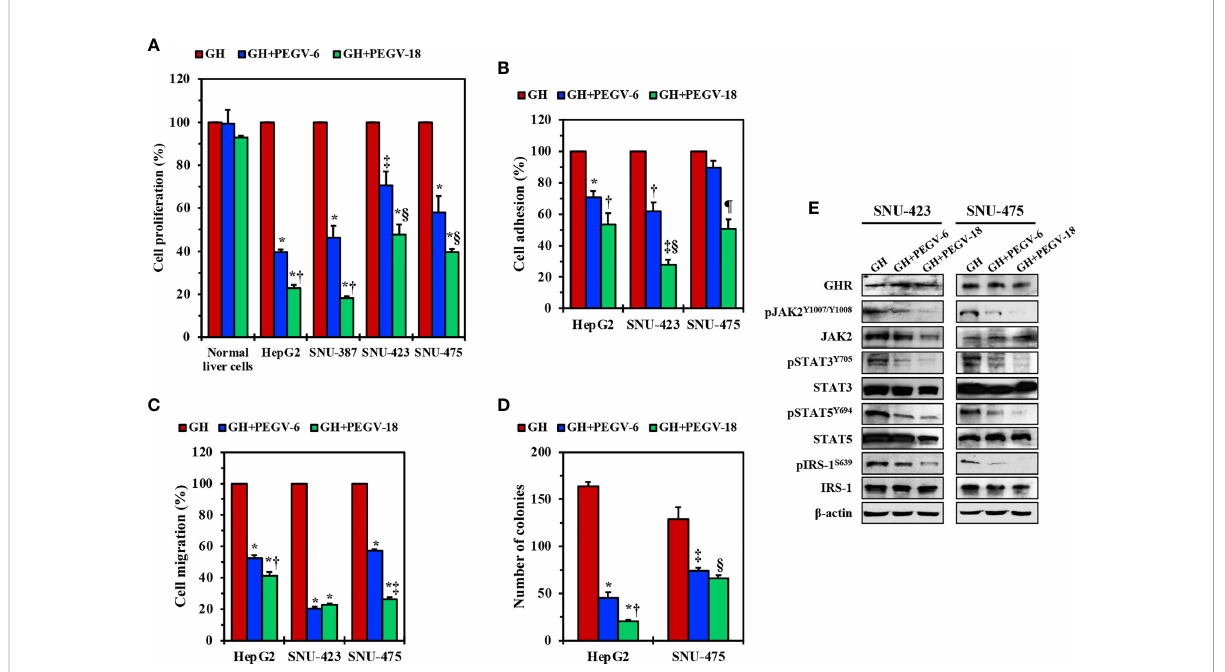
FIGURE 4 Effects of inhibition of GH/GHR signaling by using pegvisomant. In the presence of GH, pegvisomant (PEGV in the fi gure) at a concentration 6.0 or 18.0 µg/mL for 48 hours decreased cell proliferation in HepG2, SNU-387, SNU-423, and SNU-475 cells, which was not detected in normal liver cells (A) *P<0.0001 vs. GH; † P<0.0001 vs. GH+PEGV-6; ‡ P<0.01 vs. GH; § P<0.05 vs. GH+PEGV-6. In addition, pegvisomant decreased the adhesion (B) *P<0.01, ‡ P<0.001 vs. GH; ‡ P<0.001 vs. GH+PEGV-6; § P<0.0001 vs. GH; ¶ P<0.01 vs. GH and GH+PEGV-6 and migration (C) *P<0.0001 vs. GH; ‡ P<0.01 vs. GH+PEGV-6; ‡ P<0.0001 vs. GH+PEGV-6 of HepG2, SNU-423, and SNU-475 cells. Furthermore, treatment of HepG2 and SNU-475 cells with pegvisomant reduced anchorage-independent colony formation potential (D) *P=0.0001 vs. GH; ‡ P<0.05 vs. GH +PEGV-6; ‡ P=0.01 vs. GH; § P<0.01 vs. GH. Pegvisomant did not affect GHR levels of expression in SNU-423 and SNU-475 cells but signi fi cantly downregulated pJAK2, pSTAT3, pSTAT5, and pIRS-1 levels (E)